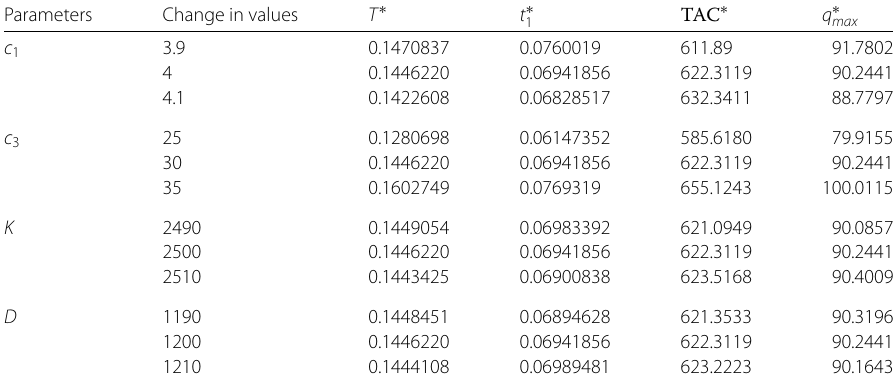
Table 7 Sensitivity table for Case 6.3 for fixed α = 1 and β = 0.5 Parameters